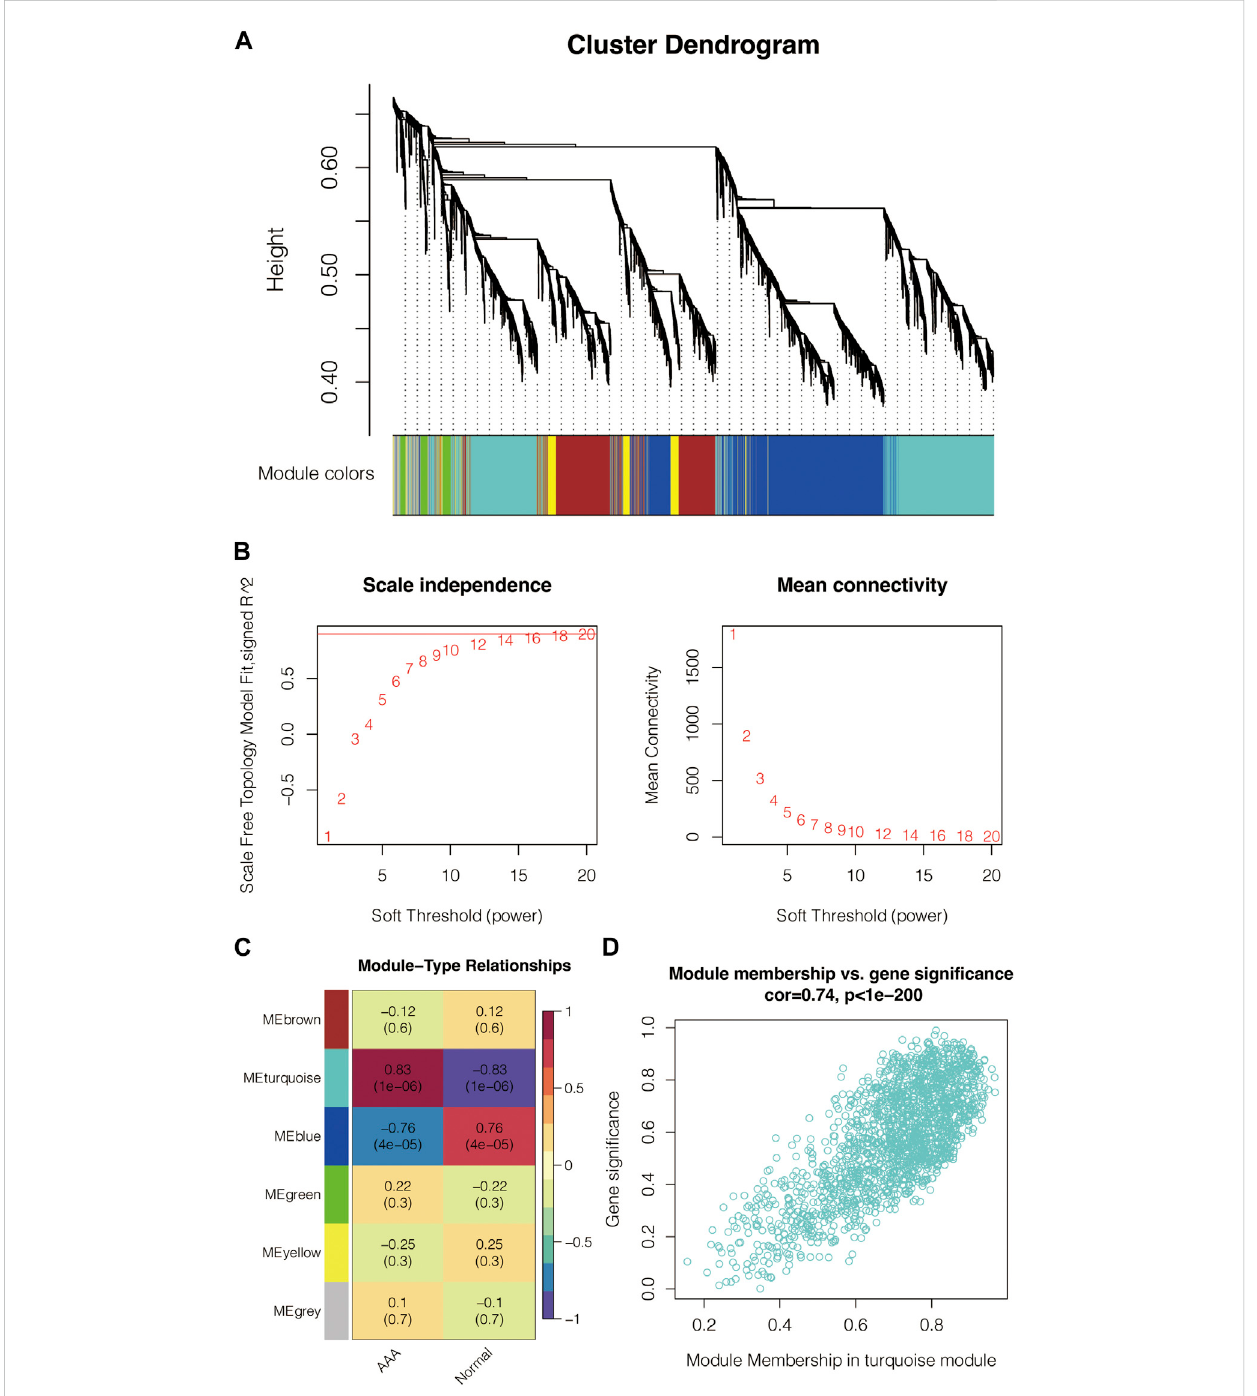
FIGURE 1 WGCNA for the AAA-related genes. (A) Cluster dendrogram of the input genes in GSE47472. (B) Scale independence and mean connectivity of the scale-free topology model in GSE47472. (C) Module-type relationships in AAA and normal samples in GSE47472. (D) Module membership and gene signi fi cance in the turquoise module in